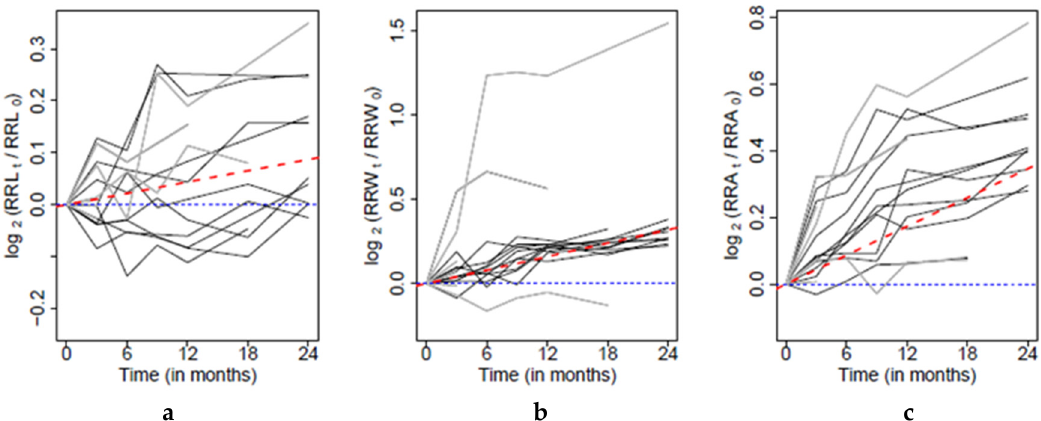
Figure 3. Graphical representation of the median growth (red dashed line) of the radiographic root length ( a ), width ( b ) and RRA ( c ). Data from patients included in the estimation are plotted by black lines, and grey lines represent patients with an anomalous postoperative development.